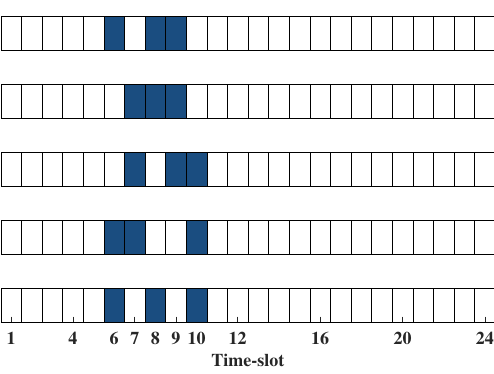
Figure 4. A typical example of shiftable loads